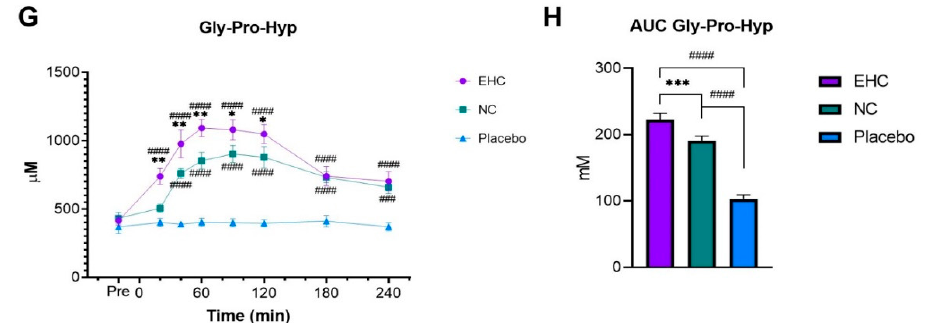
Figure 3. Postprandial plasma concentration of glycine ( A ), proline ( C ), hydroxyproline ( E ) and Gly-Pro-Hyp ( G ) after ingestion of enzymatically hydrolyzed collagen (EHC), non-enzymatically hydrolyzed collagen (NC) or placebo. Area under the curve (AUC) analysis for each concentration of glycine ( B ), proline ( D ), hydroxyproline ( F ) and Gly-Pro-Hyp ( H ) is evaluated from time = − 20 min. * Significant di ff erence between EHC and NC. # significant di ff erences between either of the collagen products and placebo. * p < 0.05, ** p < 0.002 *** p < 0.0002, **** p < 0.0001, # p < 0.05, ## p < 0.002, ### p < 0.0002, #### p < 0.0001. Values are mean ± SEM.